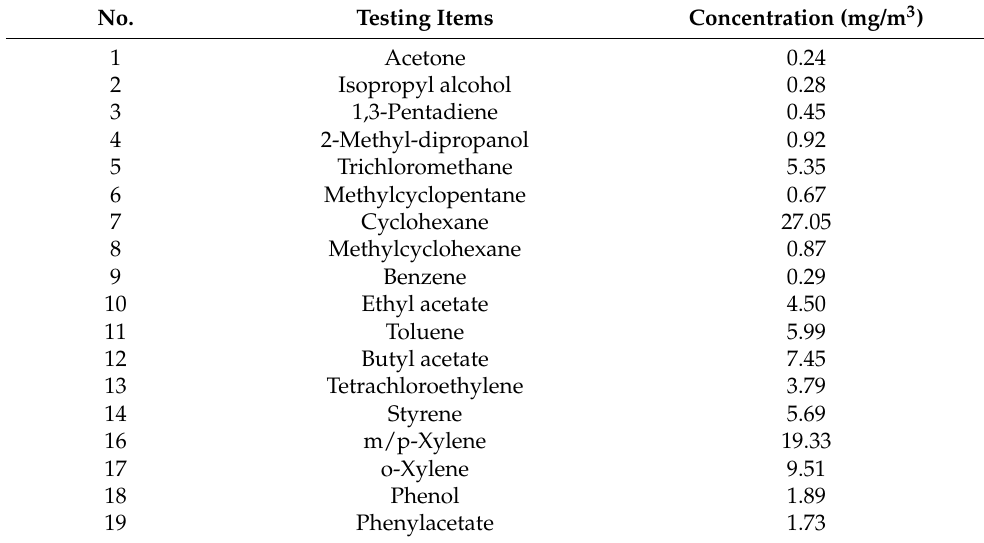
Table 1. Information about the VOC components emitted from the stack.